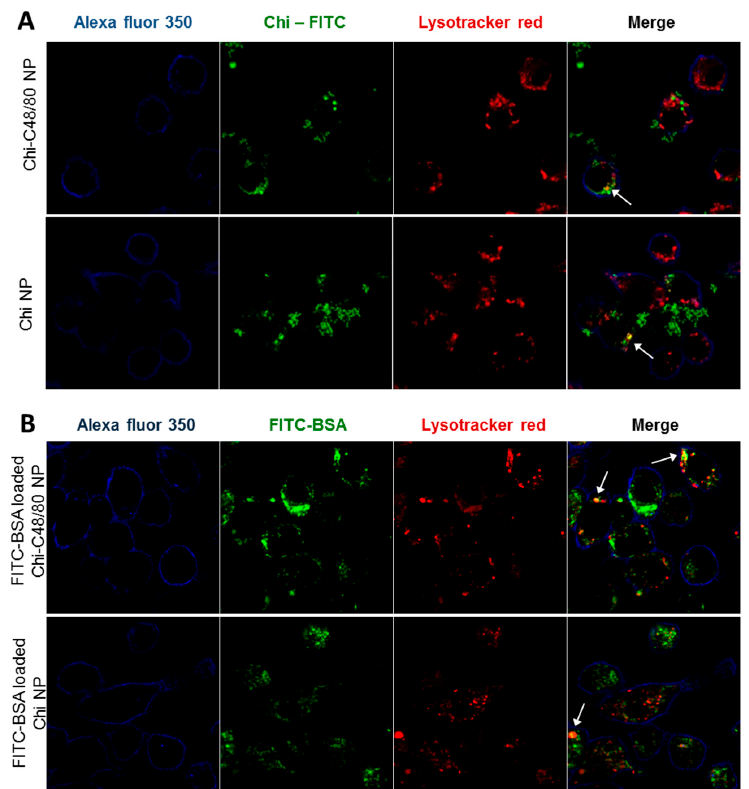
Figure 8. Evaluation of uptake by macrophages. ( A ) Uptake of nanoparticles was assessed by incubating 4 h, 100 μ g/mL RAW 264.7 cells with Chi-C48/80 NPs or Chi NPs prepared with fluorescein isothiocyanate (FITC)-labeled chitosan (green). ( B ) Uptake of the antigen loaded on nanoparticles was evaluated by incubating the cells with FITC-BSA loaded Chi-C48/80 NPs or Chi NPs. Cells were labeled with Alexa Fluor © 350 WGA (blue) to identify the membrane, and Lysotracker © Red identifies the acidic endosomes and lysosomes. Arrows in the merge image show co-localization.